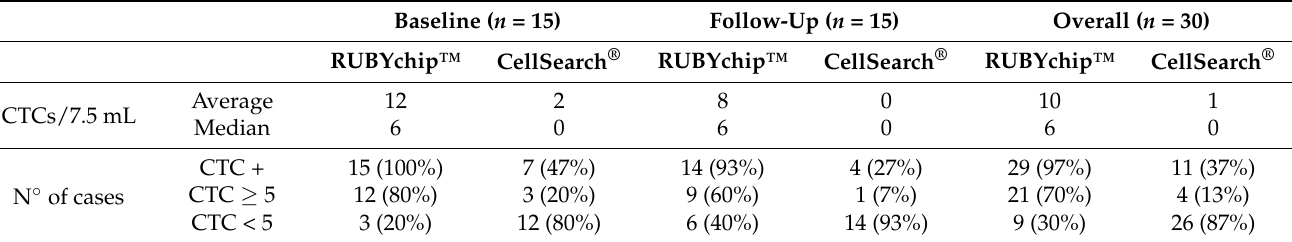
Figure 5. ( a ) Comparative scatterplot demonstrating the enumeration of CTCs using the RUBYchip™, in light grey versus the CellSearch ® system, in dark grey, for all the 30 samples analysed. ( b ) Representative images of captured cells using both technologies. CellSearch ® on the bottom, and RUBYchip™ on the top. RUBYchip™ technology allows to obtain high-resolution images, and image quality is clearly superior when compared to CellSearch ® . Isolated cells trapped between pillars of the RUBYchip™ were stained with Anti-Cytokeratin pan-FITC, Cyanine5 Anti-Human CD45, DyLight 550 Anti-ErbB2/HER2 and the nuclear marker DAPI. Table 2. Results of the CTC count using RUBYchip™ versus CellSearch ®